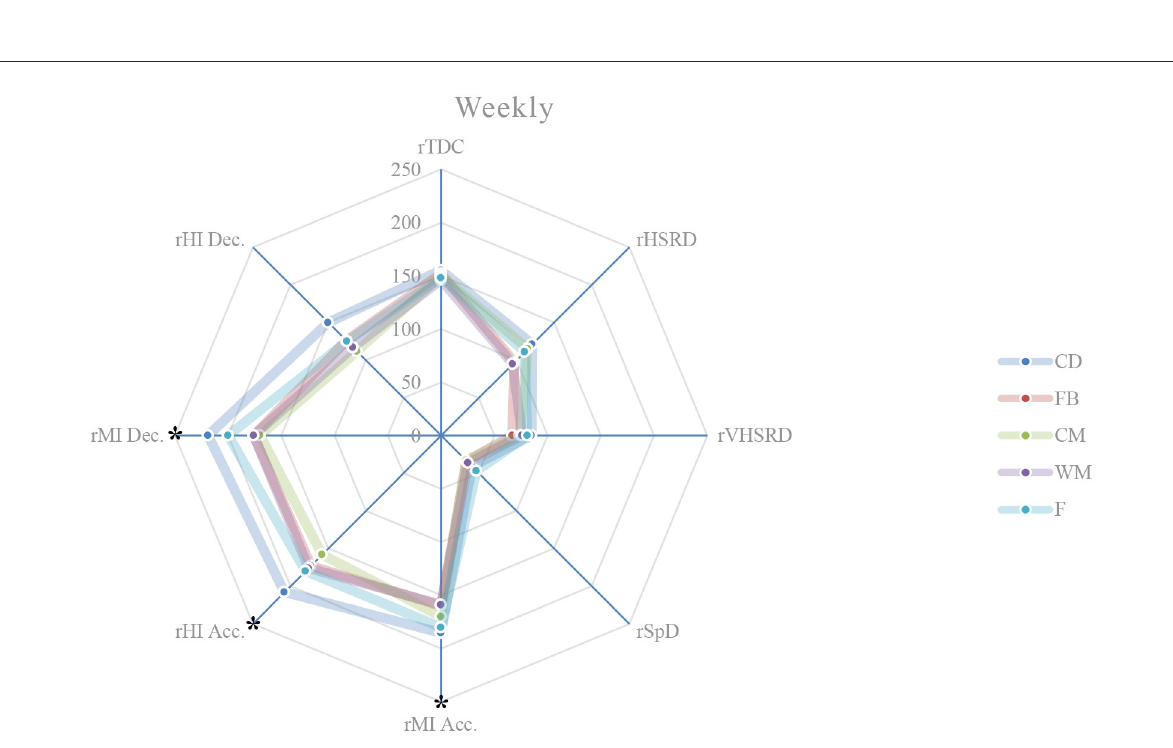
FIGURE6 Weekly external load (based on MRef) of all playing positions. *Location of the significant differences, p <